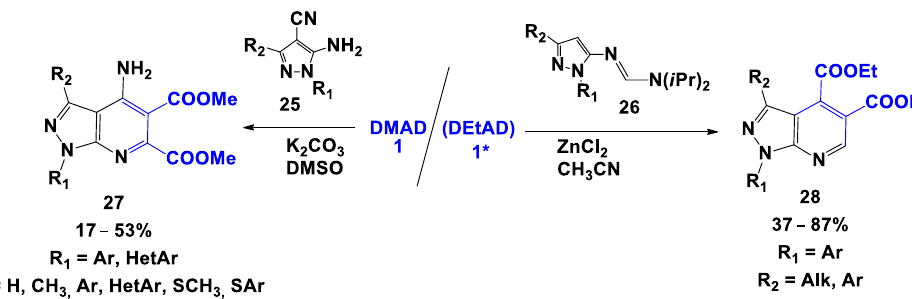
Scheme 4. Cyclization of DMAD with the involvement of C,N-dinucleophiles and systems